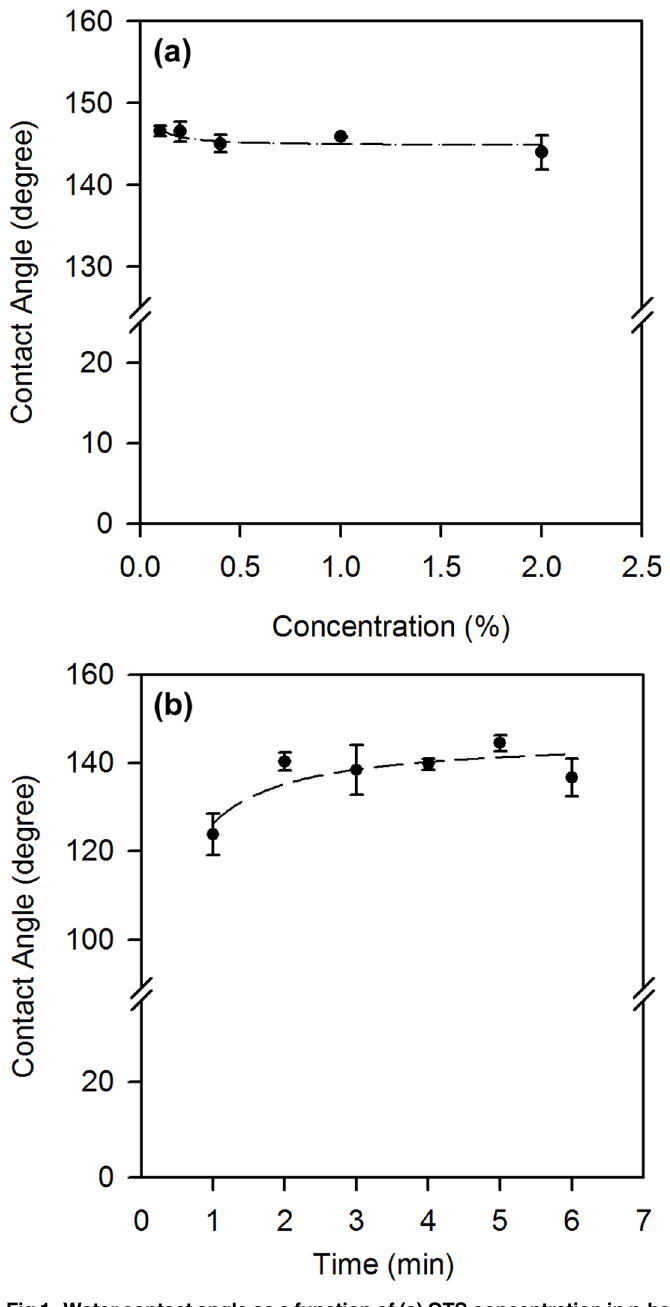
Fig 1. Water contact angle as a function of (a) OTS concentration in n-hexane at a fixed reaction time of 8 min and (b) reaction time of OTS on filter paper using a concentration of 0.1%